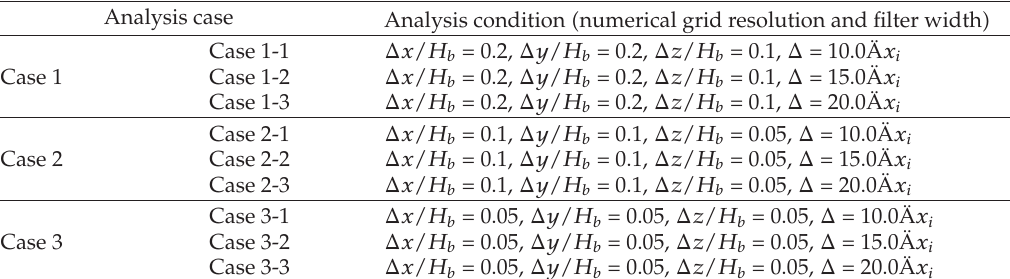
Table 2: Numerical grids and filter width in each